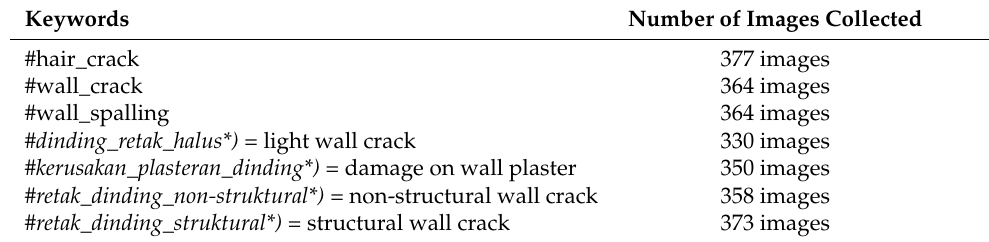
Table 1. Keywords used for the web-scrapping step.